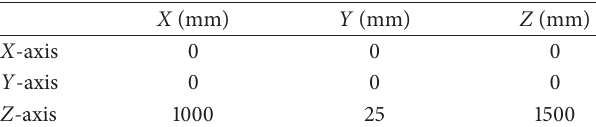
Table 3: Offset MT.